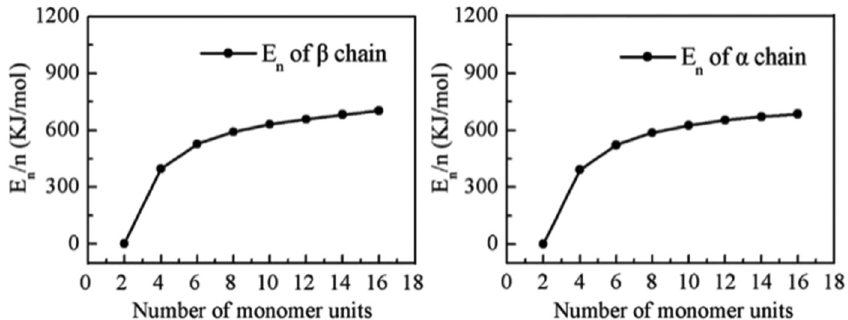
Figure 5: Energy per monomer unit of the chain in PVDF vs chain lengths [ 26 ]